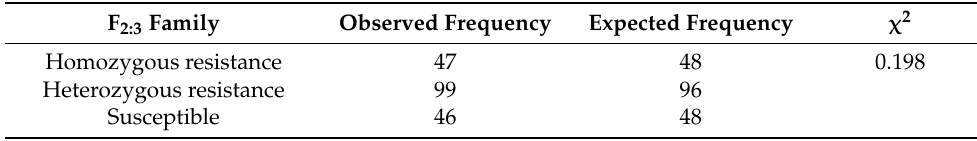
Table 1. The segregation ratio of F 2:3 families and the chi-squared test. F 2:3 Family Observed Frequency Expected Frequency χ 2 Homozygous resistance 47 48 0.198 Heterozygous resistance 99